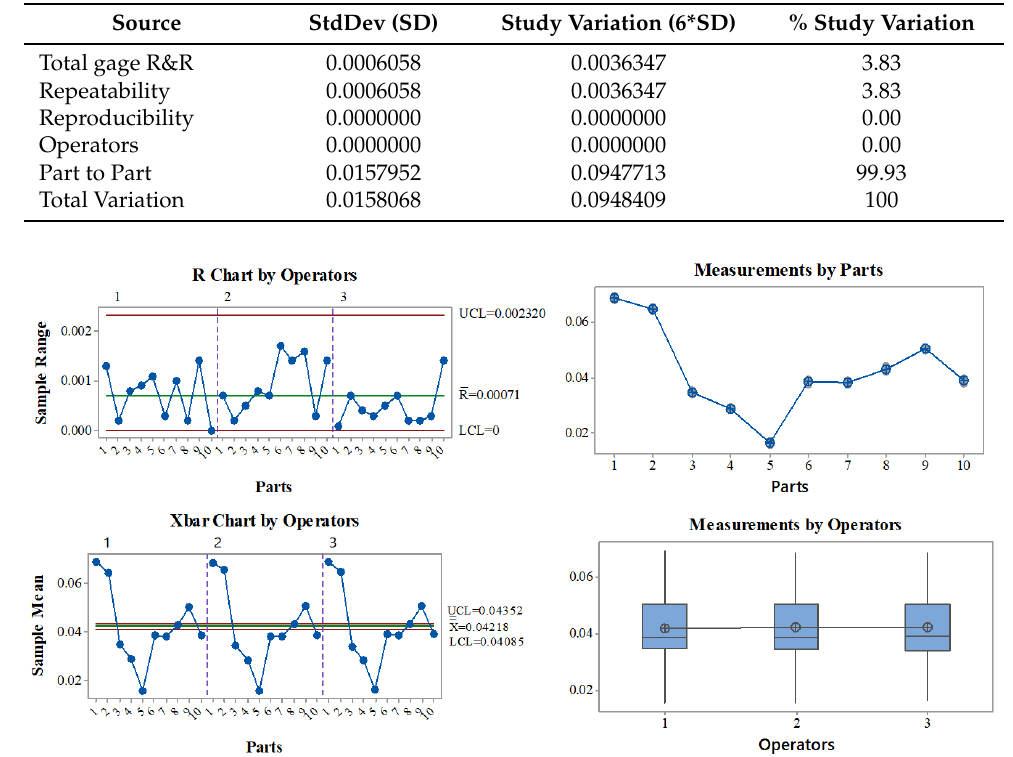
Figure 5. Graphs obtained from the gage R&R study applied to the measurement